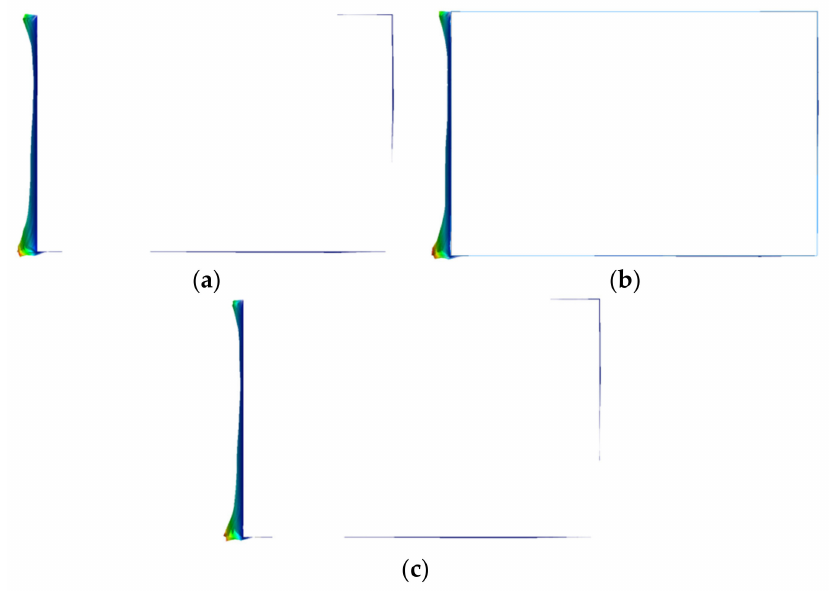
Figure 12. The ice distributions at different mesh size. ( a ) The max mesh size is 0.25 m. ( b ) The max mesh size is 0.5 m. ( c ) The max mesh size is 0.75